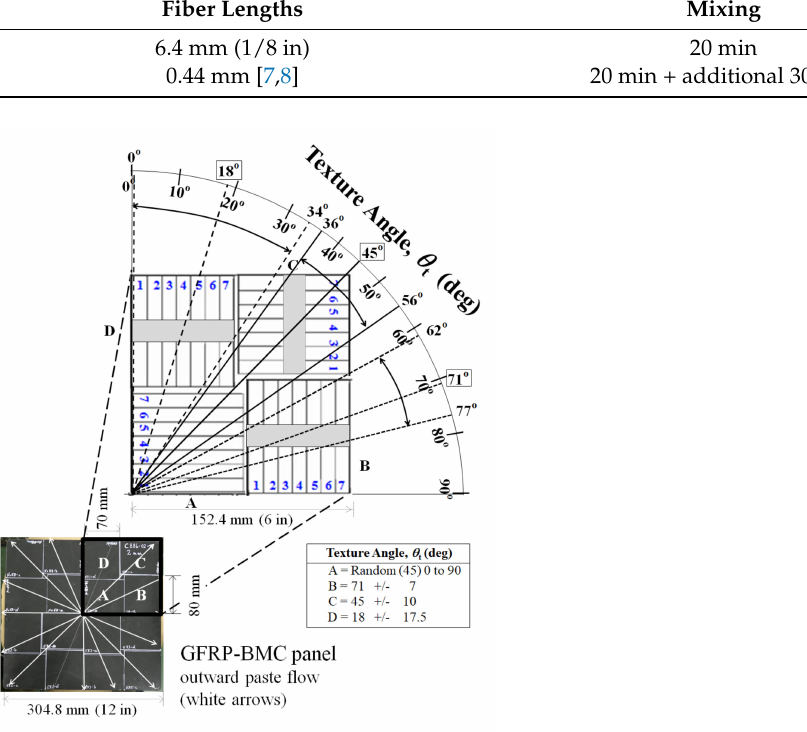
Figure 2. GFRP-BMC panel and specimen cutting configuration according to ASTM D 6110-02, taken from Faudree et al. (2018)